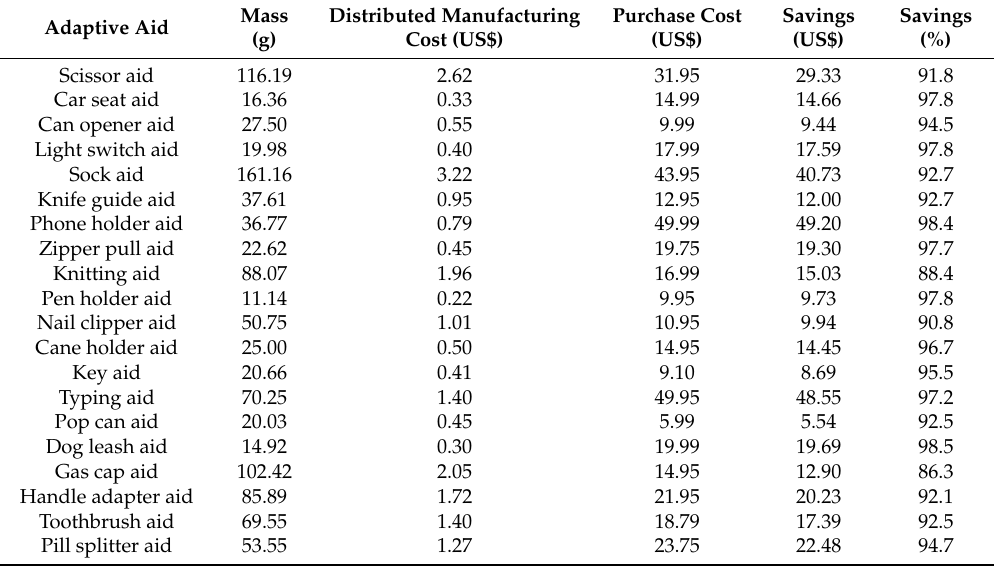
Table 2. Economic comparison of distributed manufacturing and commercial arthritis adaptive